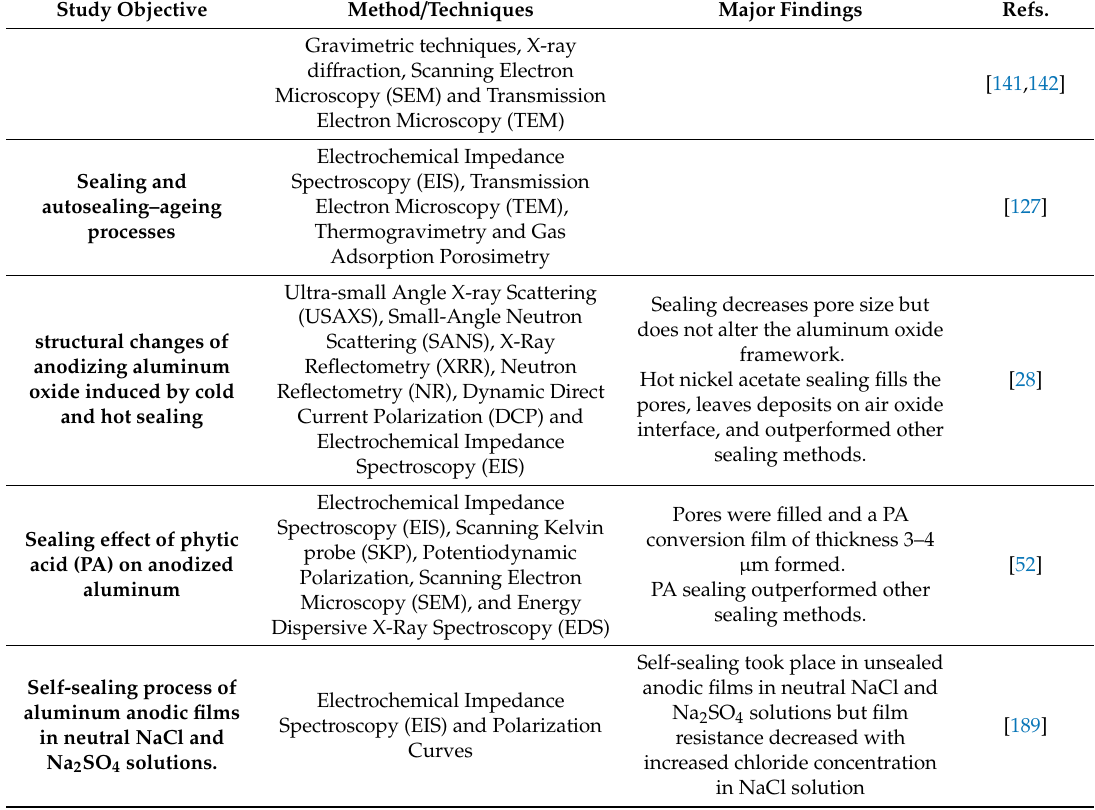
Table 4. Table of techniques used to monitor changes in oxide layer due to